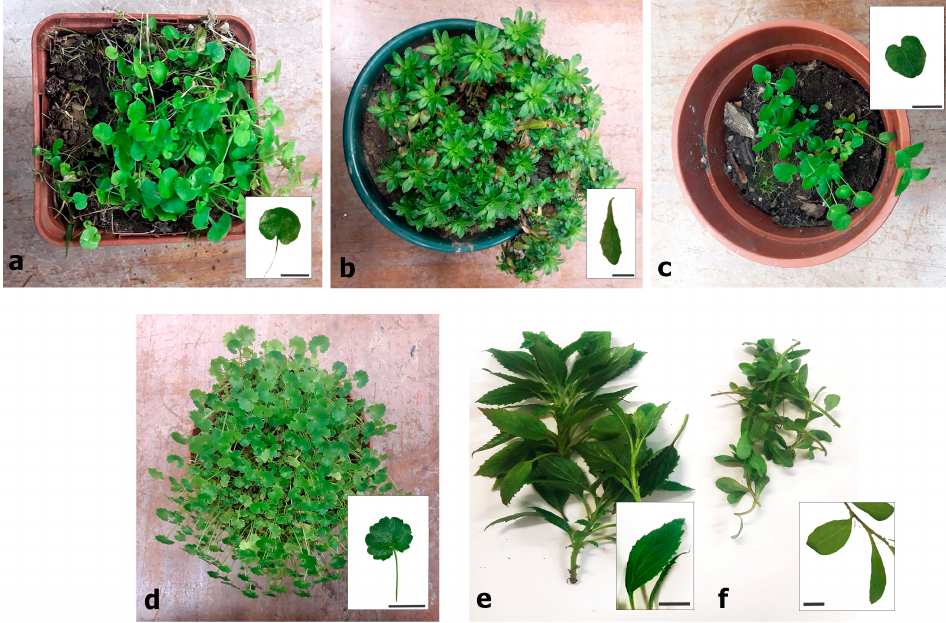
Figure 1. Pictures of fresh plant specimens used in the study. From left to right and top to bottom: ( a ) Hesperocodon hederaceus (L.) Eddie & Cupido, ( b ) Jasione laevis Lam, ( c ) Campanula rotundifolia L., ( d ) Campanula isophylla Moretti, ( e ) Trachelium caeruleum L., and, ( f ) Jasione montana L. Scale bars are 2 cm.